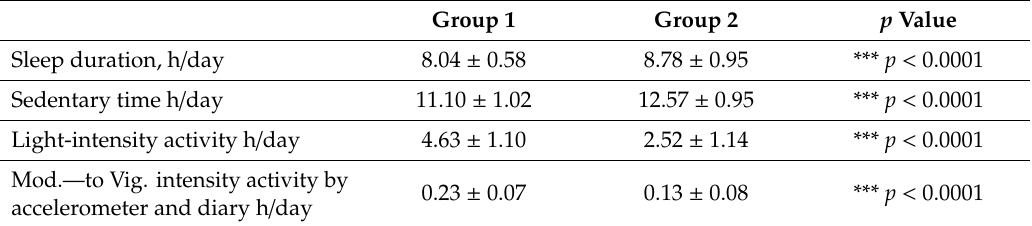
Table 1. Criteria selected for the study groups generation (Group 1: The less sedentary(SED) group, belonging to the first quartile of SED-time, and Group 2: The more sedentary group, belonging to the fourth quartile of SED-time).